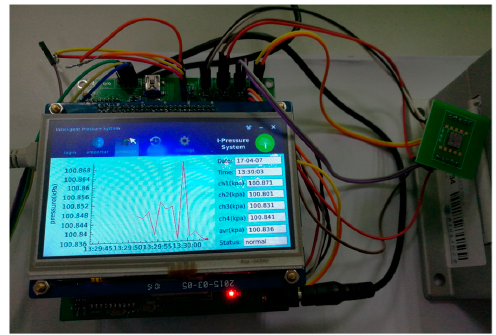
Figure 20. Pressure display interface of piezoresistive MEMS array-type pressure sensor system based on QT and embedded system.